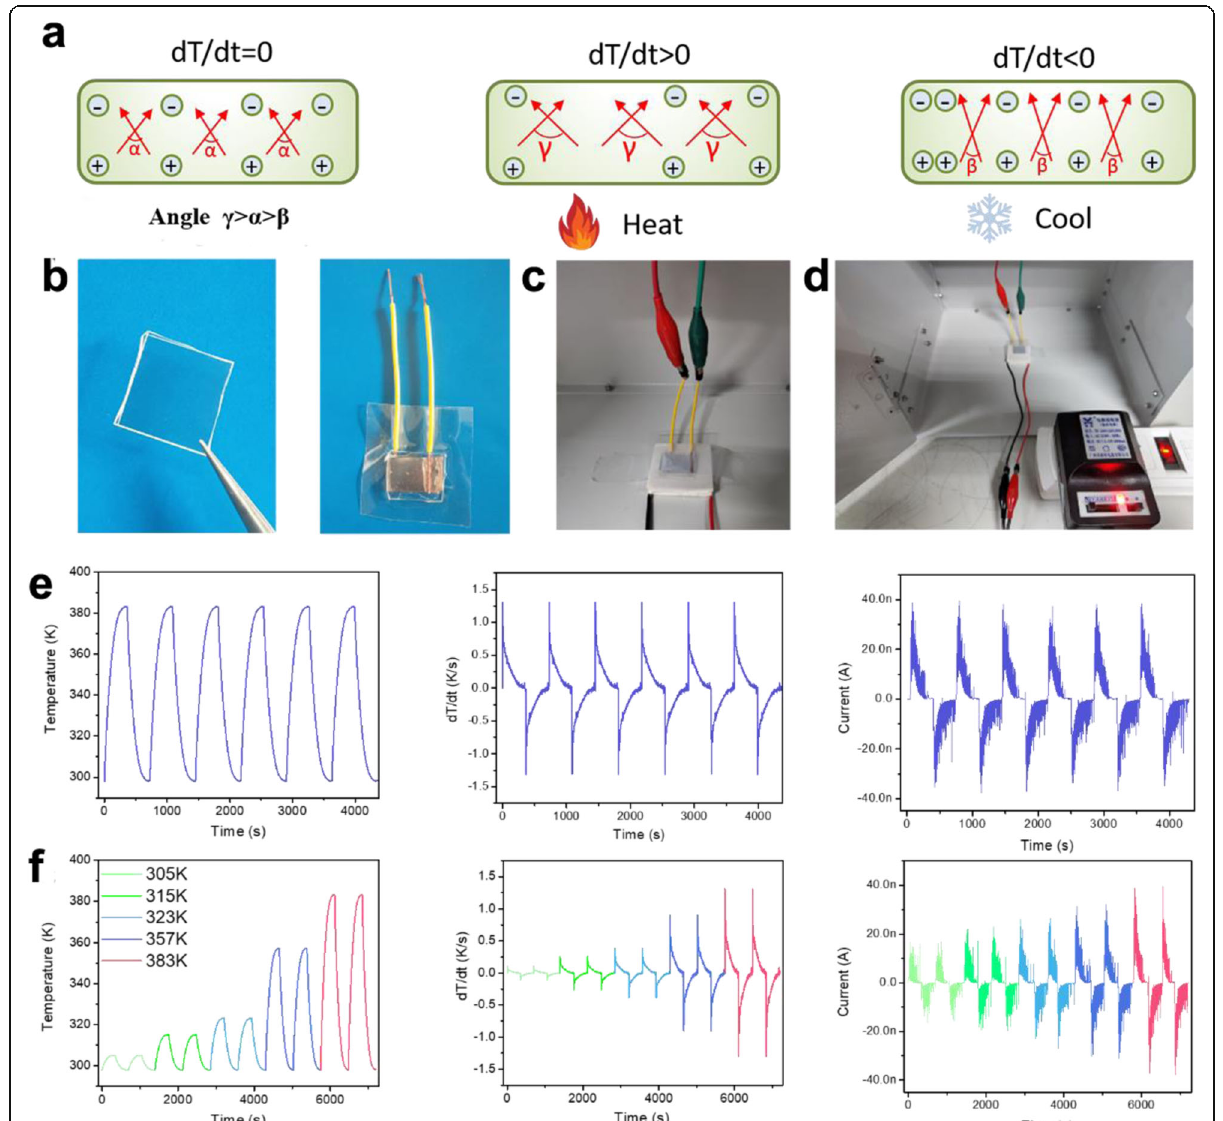
Fig. 1 Pyroelectricity of LN crystal bulk . a Schematic diagram of the pyroelectric working mechanism of the LN crystal wafer: the initial polarization state, the heated state, and the cooled state. Pyroelectric effects characterized using a heating element. b Photographs of the LN device with a piece of LN bulk wafer (2 cm × 2 cm). c A heating element used for the pyroelectric effect characterization. d Photographs of the heating element working with a DC power supply. e Pyroelectric current of the LN bulk under different temperatures. f Pyroelectric current of LN wafer with different change ranges and ramping rates of